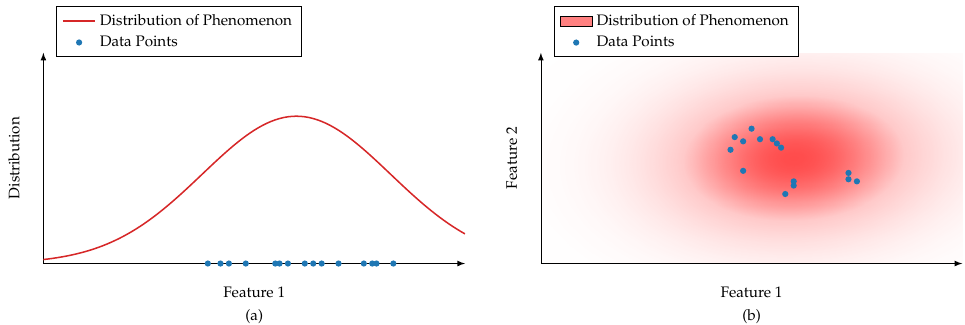
Figure 2. Two examples showcasing undersampled data: ( a ) an ill-represented one-dimensional distribution and ( b ) an ill-represented two-dimensional distribution. A two-dimensional scatter plot showcasing undersampled data. The plots show the distributions of phenomena in feature space (red). The distributions are unknown and represent the aleatoric uncertainty of the phenomena. In both examples, the sampled data points (blue) are insufficient to draw conclusions about the distributions. The missing data points are a form of epistemic